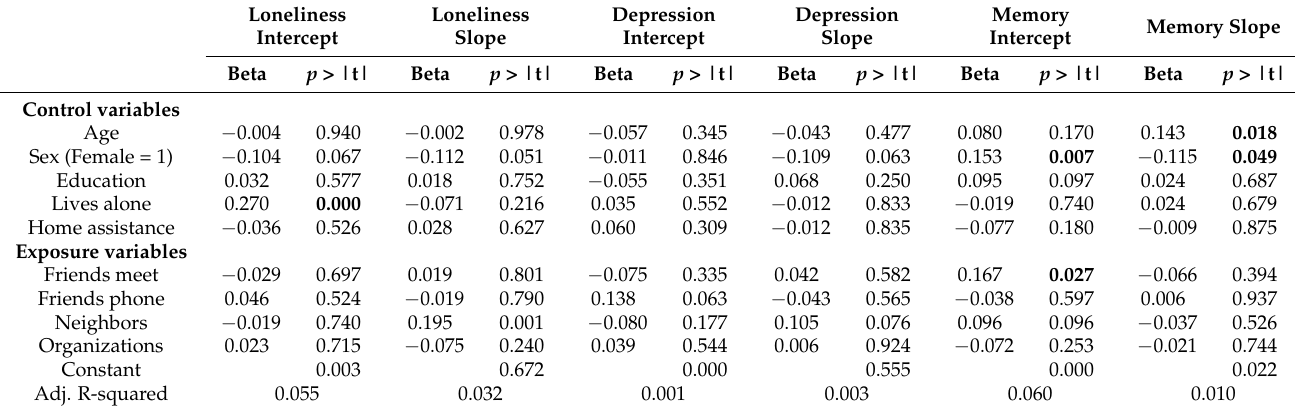
Table 5. Regression analysis on outcome variables among individuals in Profile 2 (average outcomes). n =